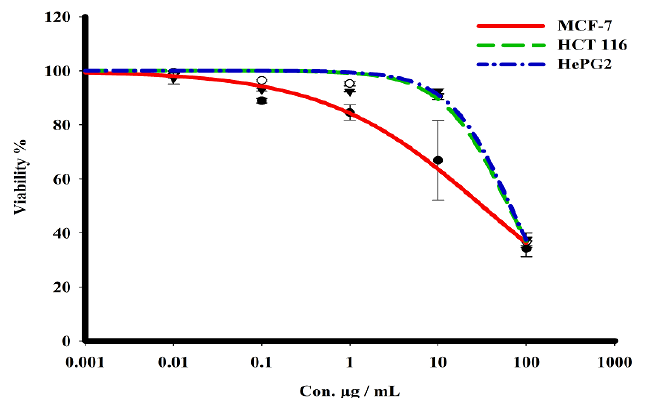
Figure 8. The dose–response curve of biosynthesized AgNPs from cell filtrate of Streptomyces sp. ASM23 on the cytotoxicity in MCF-7, HePG2, and HCT 116 cell lines. Cells were exposed to biosynthesized AgNPs from cell filtrate of Streptomyces sp. ASM23 with different concentrations of compounds for 72 h. Cell viability was detected by SRB stain.